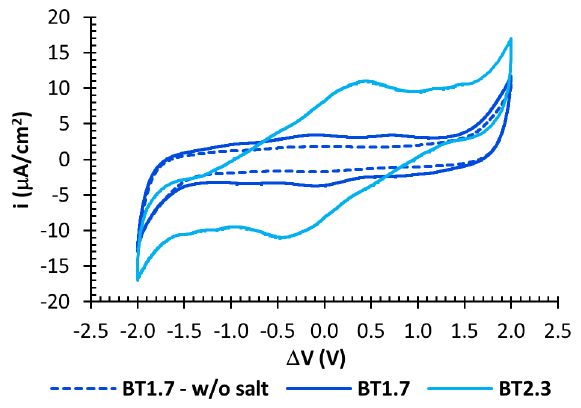
Figure 5. Cyclic voltammetry of the samples with BMIM(TFSI) ionic liquid, collected at 10